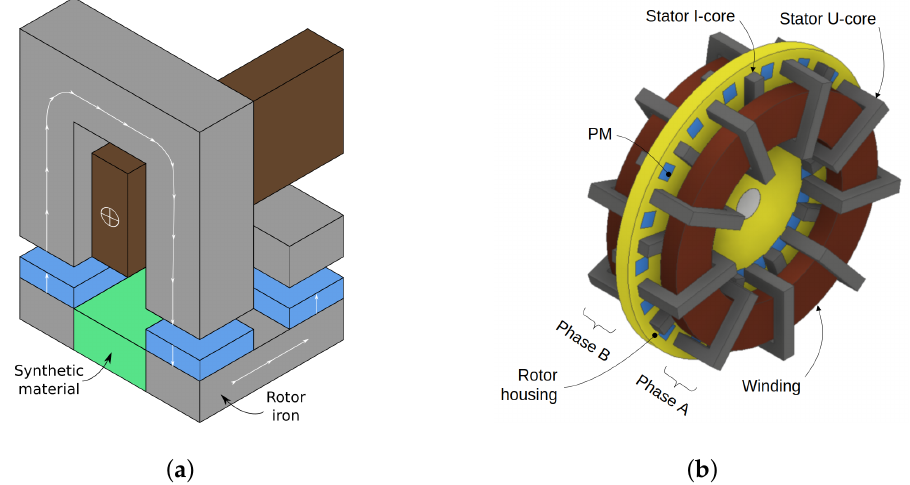
Figure 17. Two TF designs with synthetic material in the rotor: ( a ) separated rotor parts, ( b ) disk rotor and axial gap